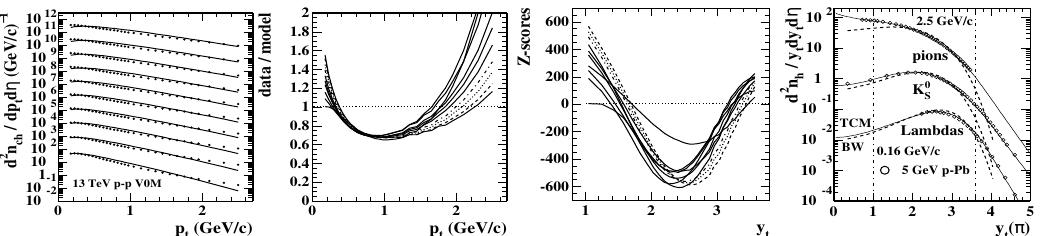
Figure 6: First: Blast-wave model (solid) vs V0M spectra (points). Second: Data / model ratios. Third: Corresponding Z-scores. Fourth: BW model applied to 5 TeV p -Pb